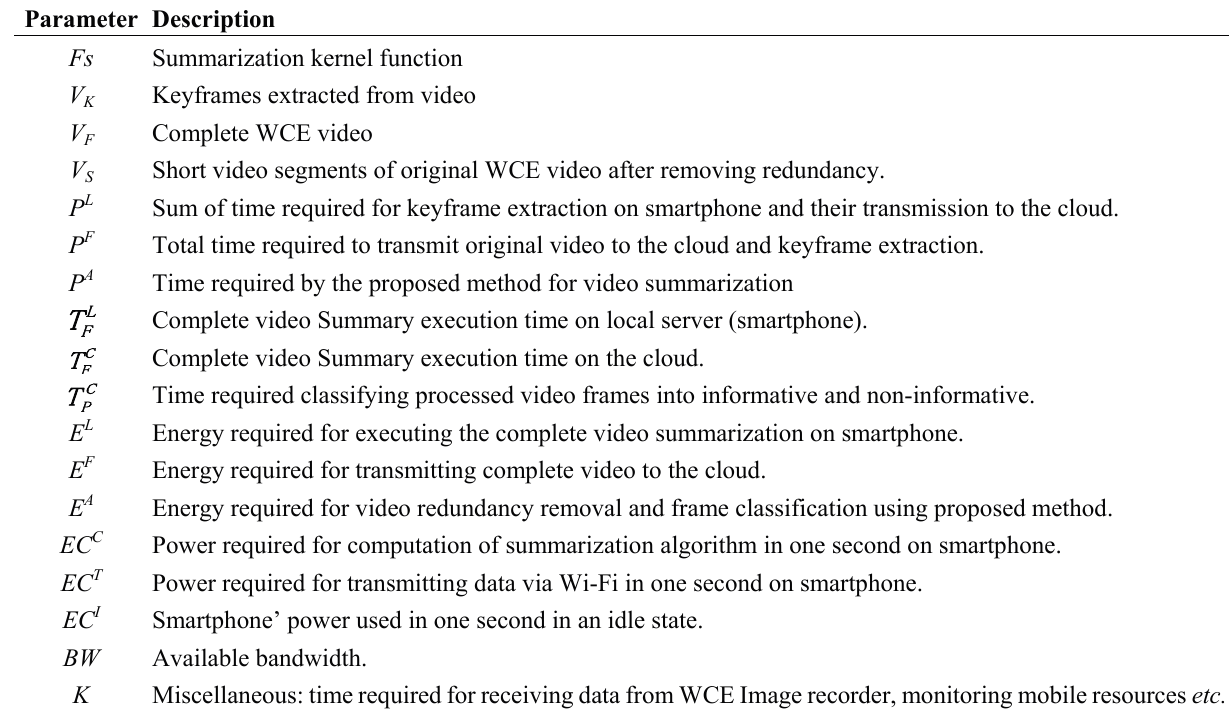
Table 2. Parameters of the simulation